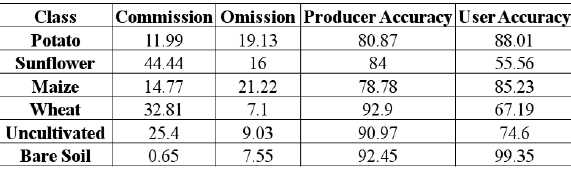
Table 2. Percentages of errors of commission, errors of omission, Producer’s and User’s accuracies for each class